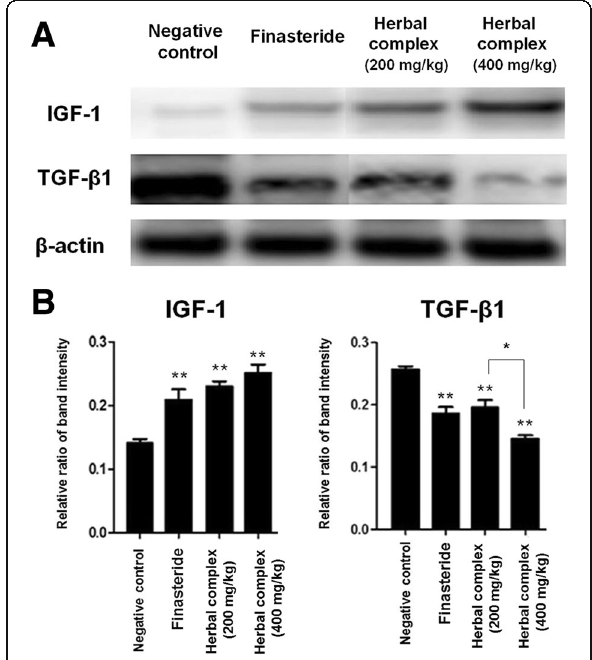
Fig. 4 IGF-1 and TGF- β 1 Western blot analysis. a A western blot